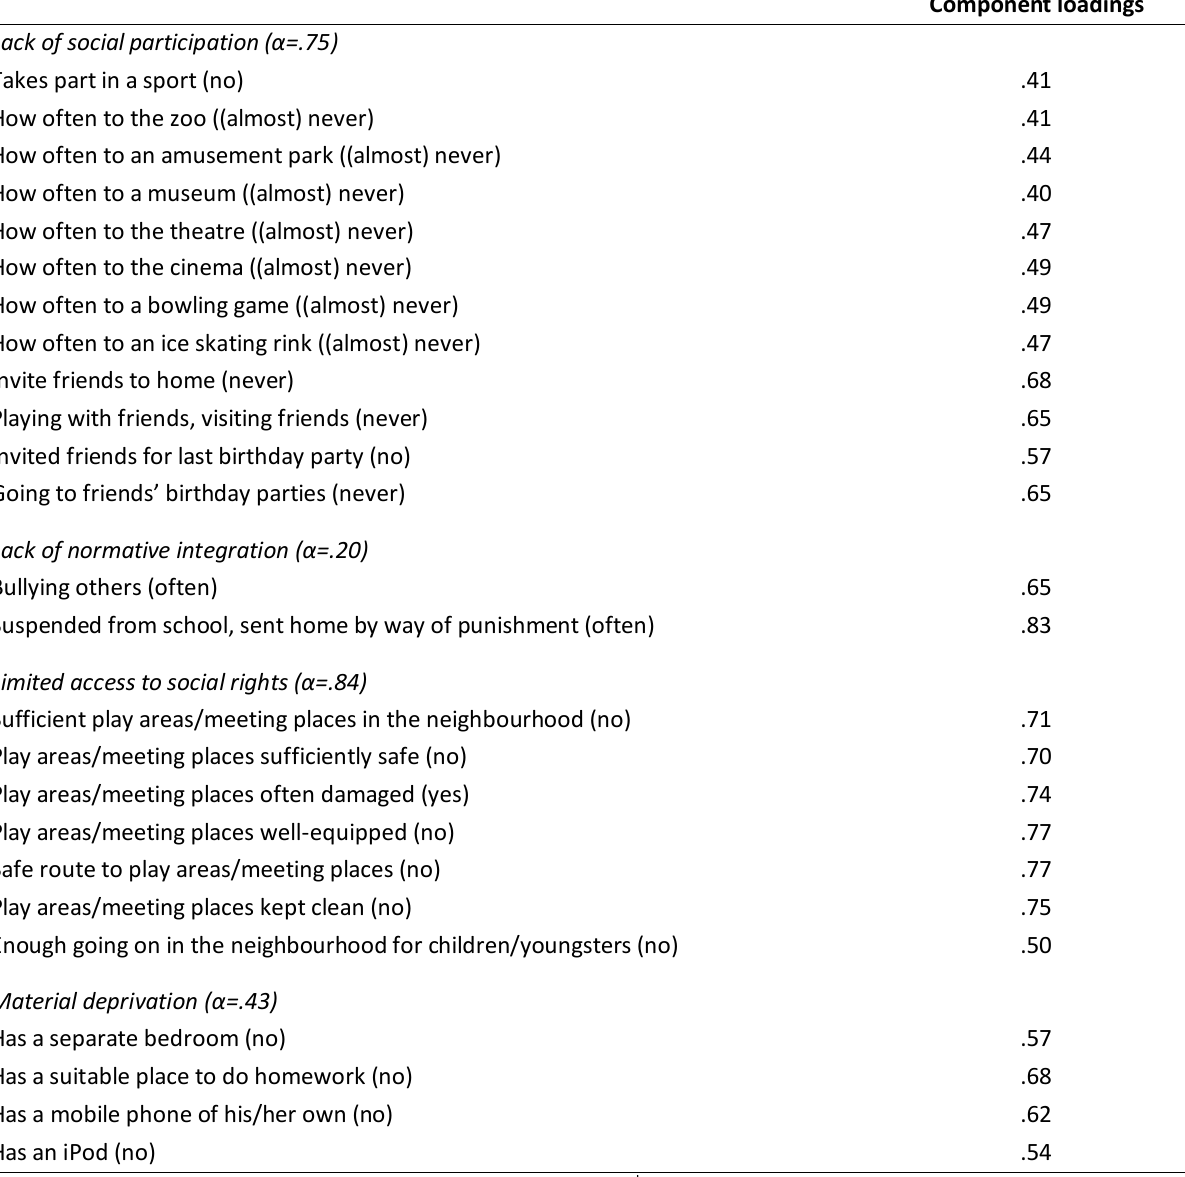
Table 1. Scales for four sub-dimensions of social exclusion (CatPCA, children aged 8−17 years; n = 1782) a, b .